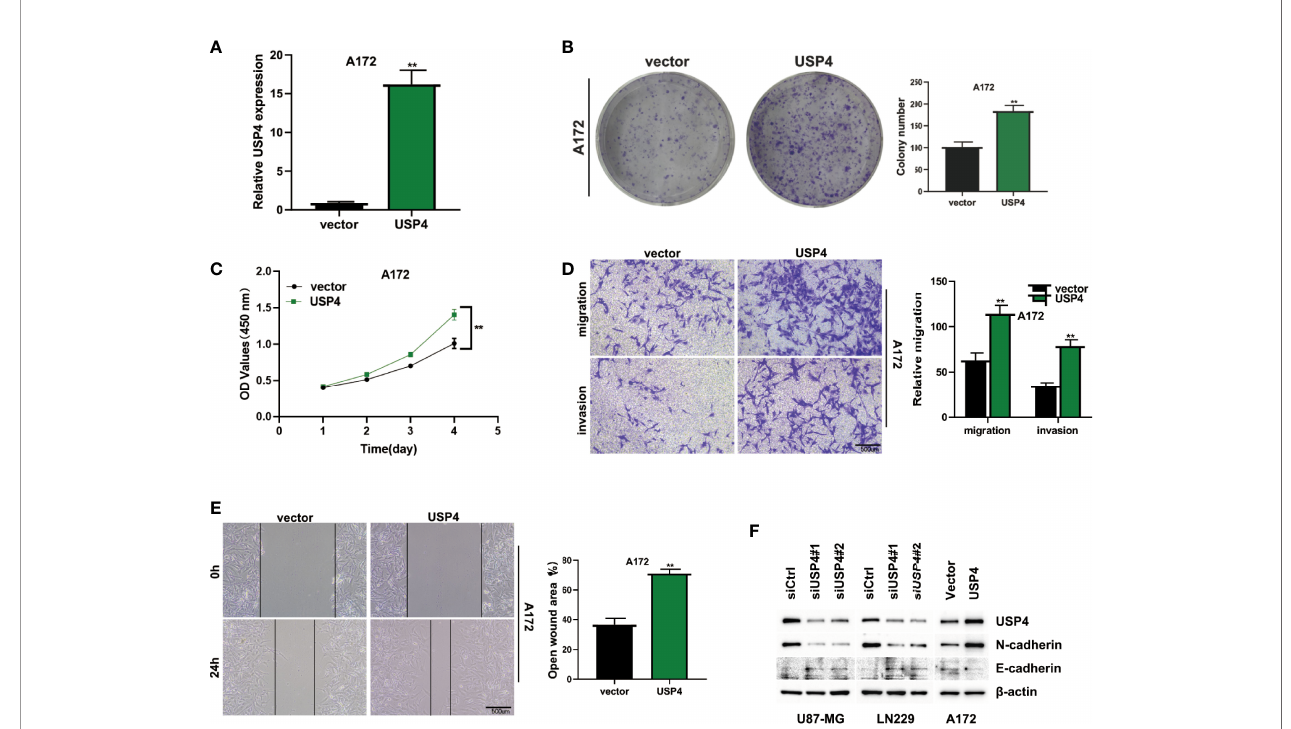
FIGURE 12 | In vitro experiment after USP4 overexpression. (A) USP4 was overexpressed in A172 cell line after plasmid transfection (**P < 0.01). (B) Clonal formation experiments veri fi ed the changes of colony formation ability after USP4 overexpression (**P < 0.01). (C) CCK-8 assay showed that USP4 overexpression signi fi cantly enhanced the viability of A172 cell lines (**P < 0.01). (D) Transwell assay showed that USP4 overexpression signi fi cantly enhanced the ability of A172 cell line to migrate and invade (**P < 0.01). (E) Wound healing experiments showed that the migration ability of A172 cell line was signi fi cantly enhanced after USP4 overexpression (**P < 0.01). (F) Western-blotting assay was performed to verify the knockdown and overexpression ef fi ciency of USP4 and explore the relationship between USP4 and EMT-related